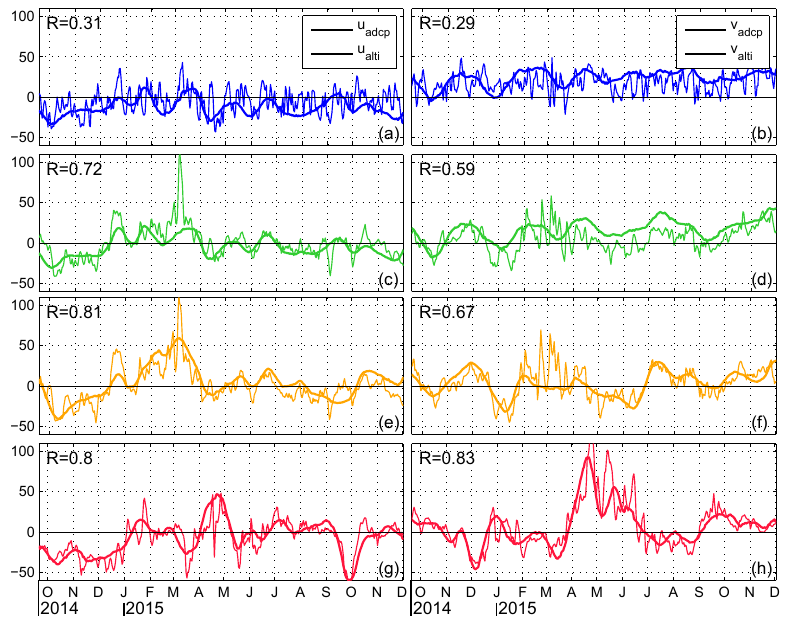
Figure 3. Temporal evolution of the near-surface velocities recorded at the last bin by the upward-looking ADCP (thin lines) and the surface geostrophic velocity derived from satellite altimetry (bold lines). The u (left column) and v (right column) component of the current velocities (cms − 1 ) are represented at M1 ( a, b – blue line), M2 ( c, d – green line), M3 ( e, f – yellow line) and M4 ( g, h – red line). The correlation coefficient value ( R ) is indicated in the top left corner of each panel.